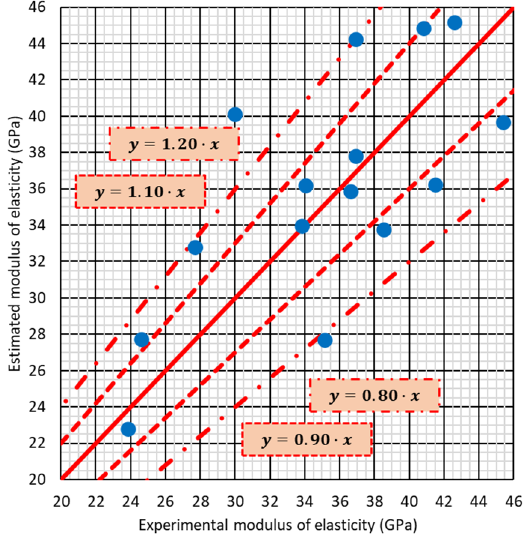
Figure 8. Validation of Equation (6) through other studies in the literature regarding SCC containing RA [56,57].